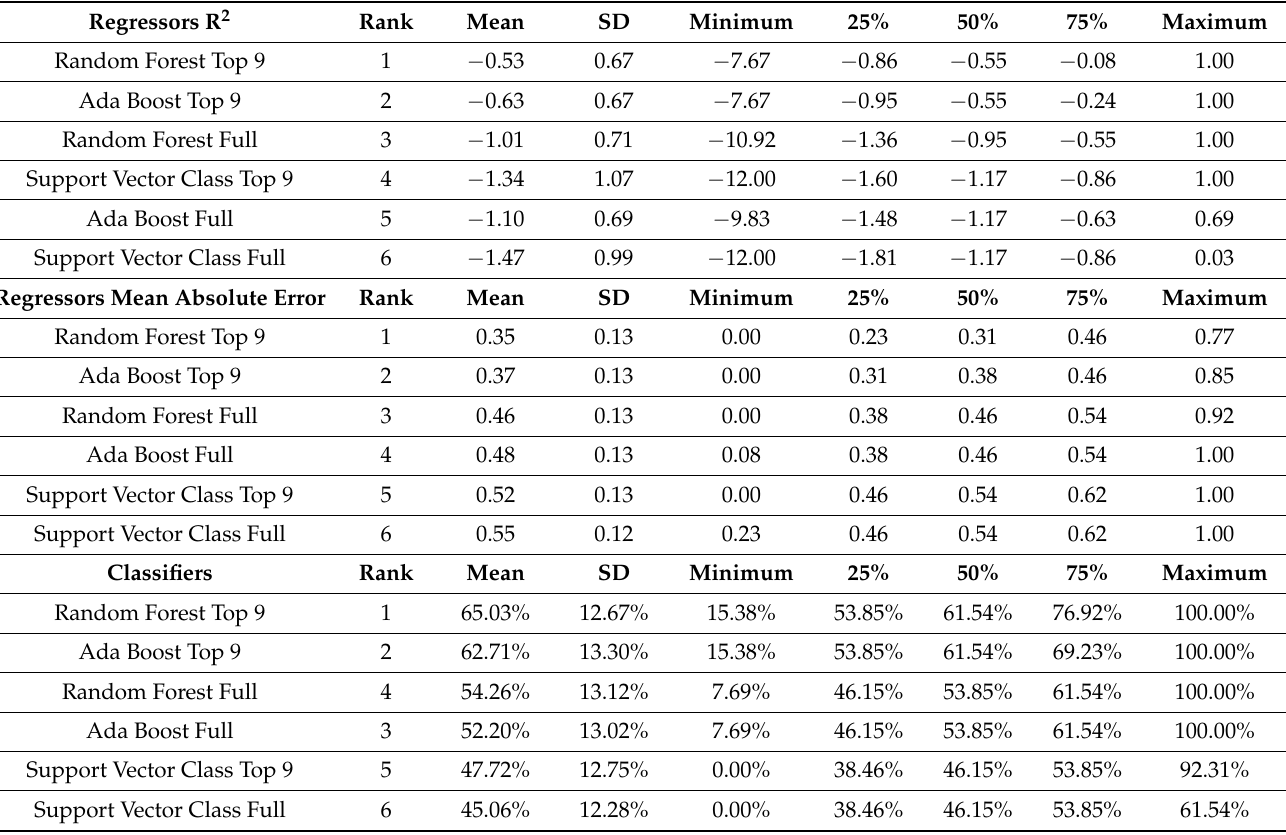
Table 3. Model evaluation